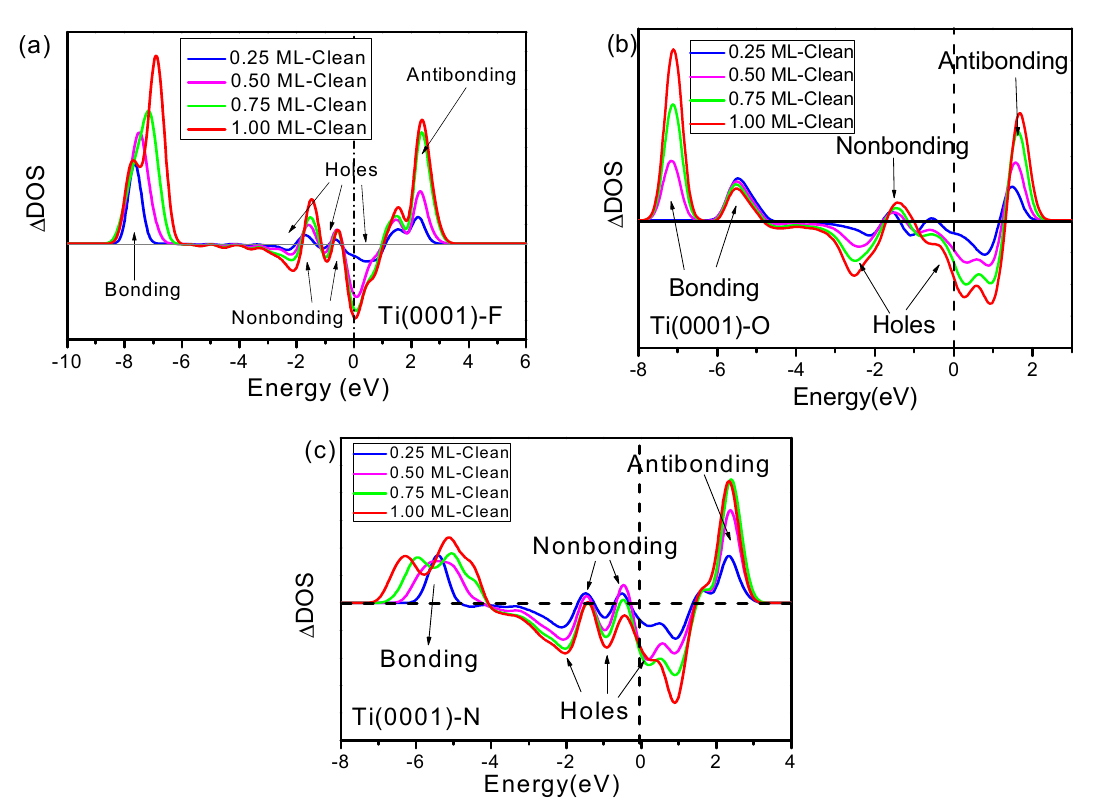
Figure 5. ( a ) Changes in the DOS ( Δ DOSs) of the Ti(0001) surface at various F-atom adsorption concentrations compared to ( b ) O atom adsorption and ( c ) N atom adsorption. Three adsorbed atoms led to the same four-electron structure change features corresponding to antibonding dipoles, nonbonding states, bonding states, and holes. The DOS features between − 8.0 and − 6.0 eV arise from derivative Ti-F bonds that are stronger than the original Ti-Ti bonds, which stabilizes the system by lowering its overall